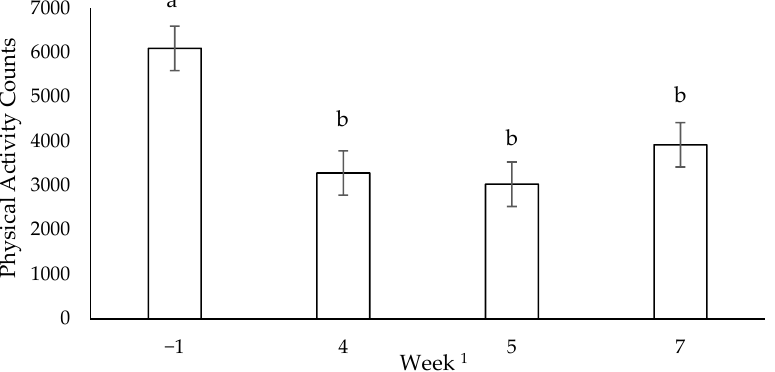
Figure 1. Mean voluntary activity counts during rest days for all dogs (n = 12) throughout 10 weeks of incremental conditioning; ab columns with different letters are different ( p < 0.05); error bars represent standard error of the mean; 1 distances run were 3 km (week − 1), 30.1 km (week 4), 35.8 km